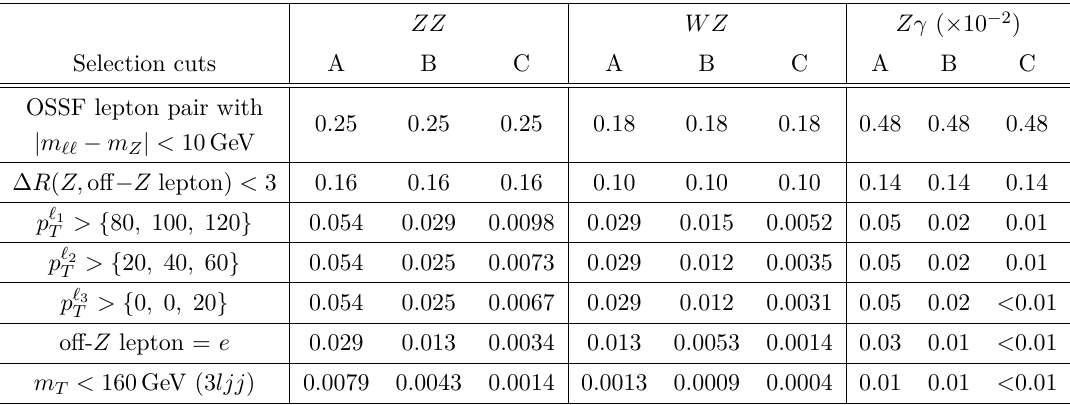
Table 2 . Efficiencies for the background events after applying the selection cuts corresponding to √ the new analysis performed at s = 13 TeV . Efficiencies are presented as the number of events which are selected over the number of initial events. The regions represented by { A, B, C } correspond to different values of the mass of the VLL, { M E < 300 , 300 ≤ M E < 400 , M E ≥ 400 } , in GeV. We have included in the generation only leptonic decays of the Z and W into electron, muons and taus but apply our cuts only to final state electrons and